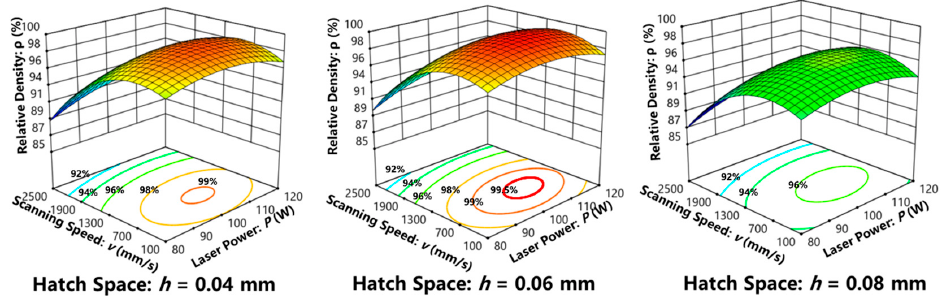
Figure 3. Effect of P and v on density with fixed h . Table 4. The LPBF parameters of Ti-Ta samples for